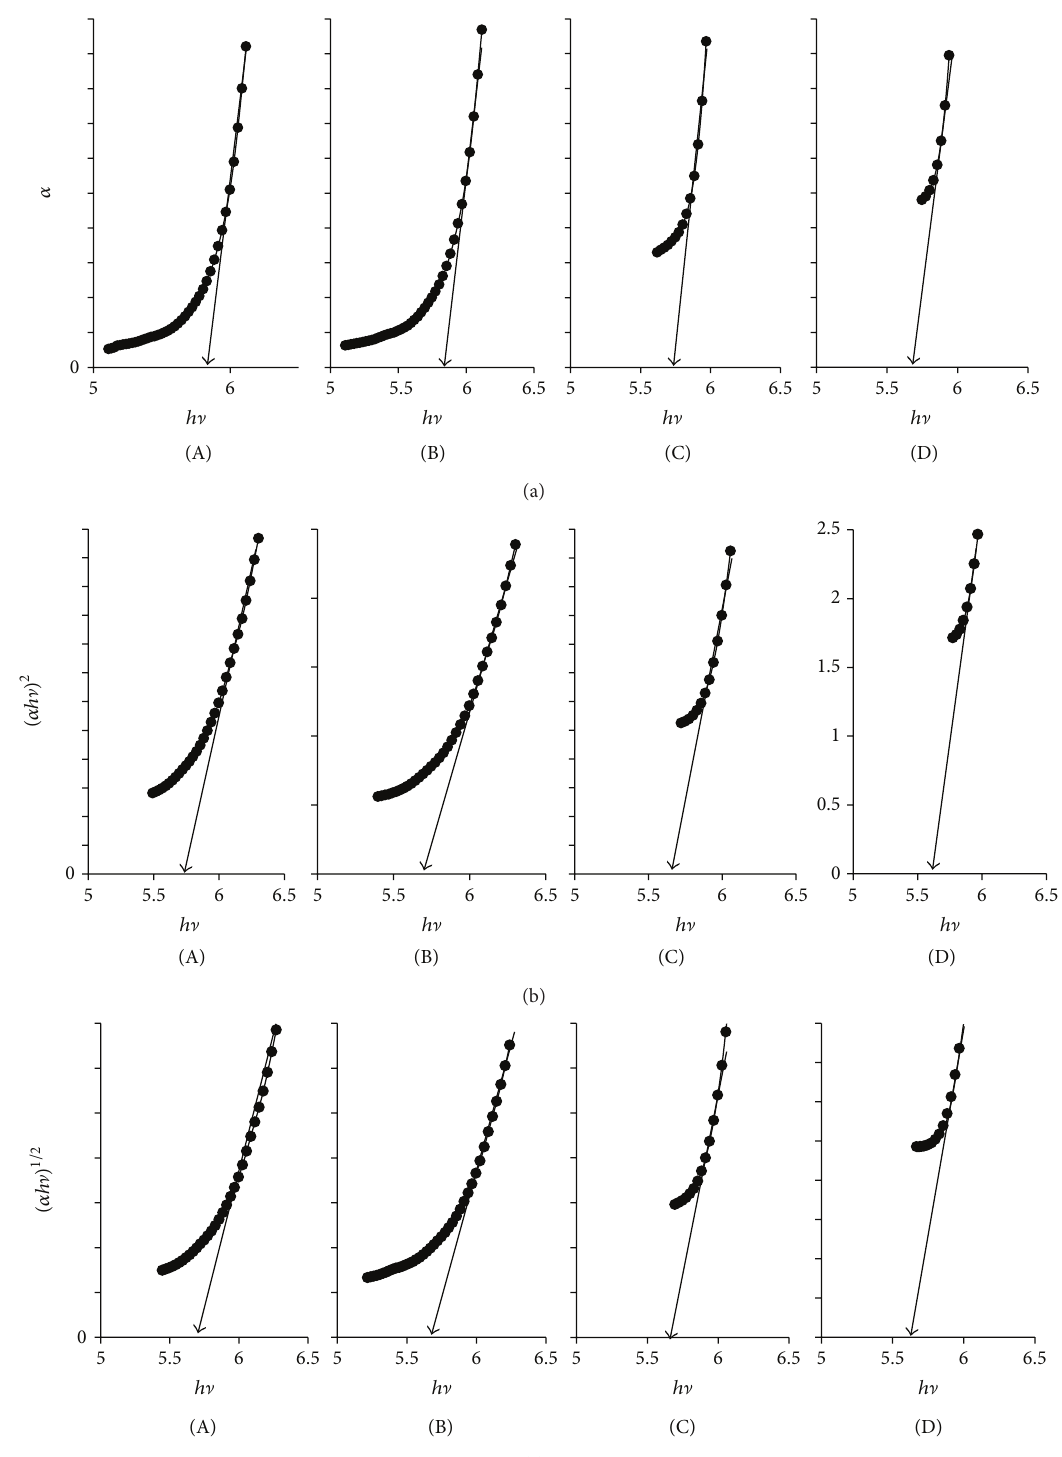
Figure 6: (a) Plot of 𝛼 versus ℎ𝜐 (photon energy); (b) plot of (𝛼ℎ𝜐) 2 versus ℎ𝜐 (direct band gap); (c) plot of (𝛼ℎ𝜐) 1/2 versus ℎ𝜐 (indirect band gap) for (A) pure PEO; (B) PEO and LiSO 3 CF 3 ; (C) PEO and LiSO 3 CF 3 and DBP; (D) PEO and LiSO 3 CF 3 and DBP + ZrO 2